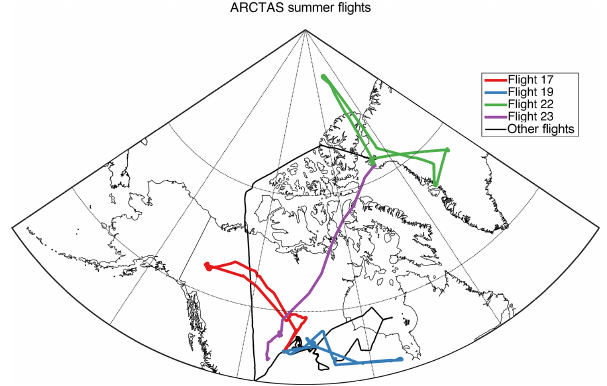
Figure 5. Map of ARCTAS-B deployment over the North American Arctic. Colored flights correspond to flight data results analyzed in Figs. 7 and